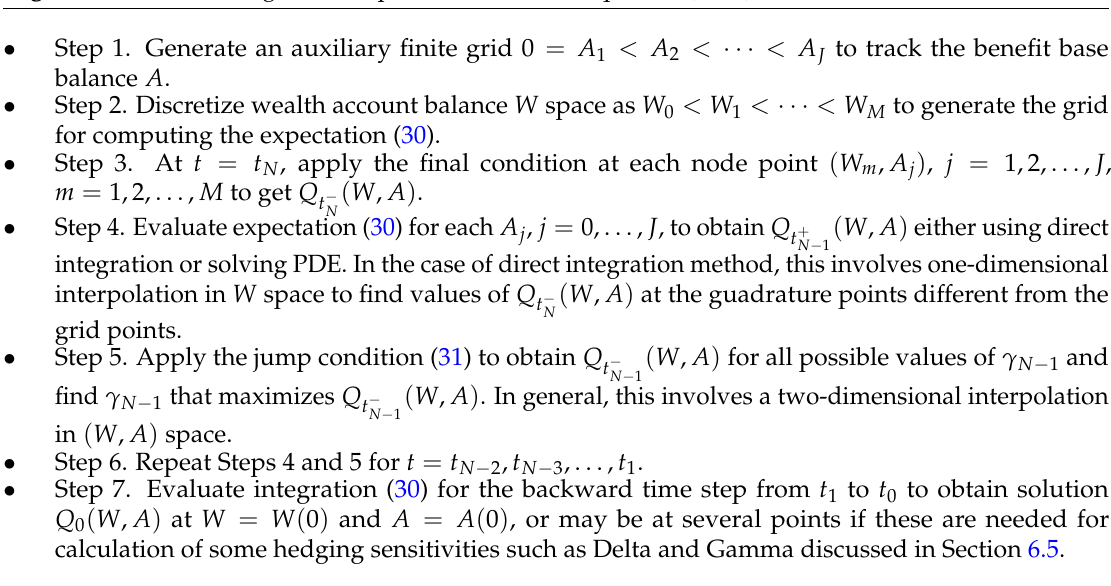
Algorithm 1 Direct Integration or partial differential equation (PDE)